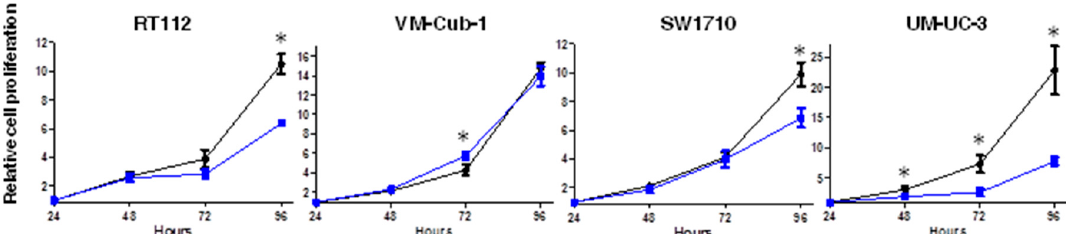
Figure 2. Effect of HDAC5 on cell proliferation. The cell proliferation capacity of vector-only and HDAC5-transduce cell lines was analyzed by MTT assays at 24, 48, 72, and 96 h. The 24 h value of each cell line was set as “1” at the origin of the graph. Values represent means ± SD (error bars) of quadruplicates. Asterisks denote significant differences ( t -test, * p < 0.05). Blue: HDAC5 cells; black: vector-only cells.